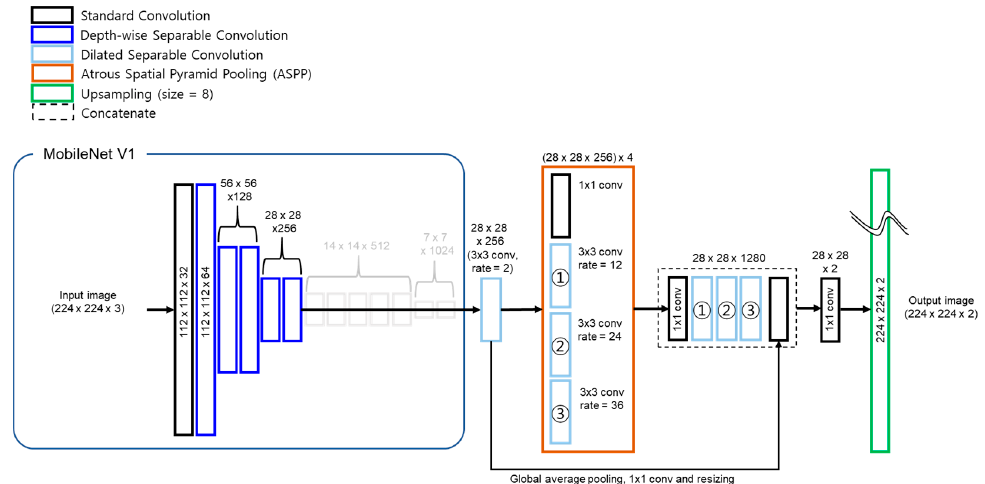
Figure 3. Model architecture of UNet.